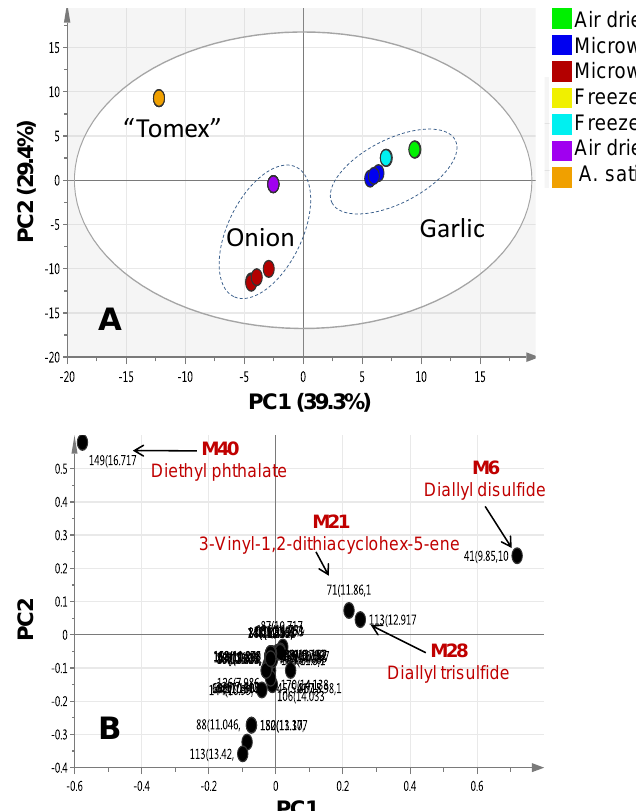
Figure 1. Solid-phase microextraction coupled to gas chromatography mass spectrometry) (SPME-GC/MS) based principal component analysis (PCA) of fresh and dried A. sativum and A. cepa red cv. specimens. ( A ) Score plot of PC1 and PC2 scores; ( B ) Loading plot for PC1 components contributing peaks and their assignments, with each metabolite denoted by its mass/r.t. (min) value: M6; diallyl disulphide, M21; 3-Vinyl-1,2-dithiacyclohex-5-ene, M28; diallyl trisulphide and M40; diethyl phthalate.